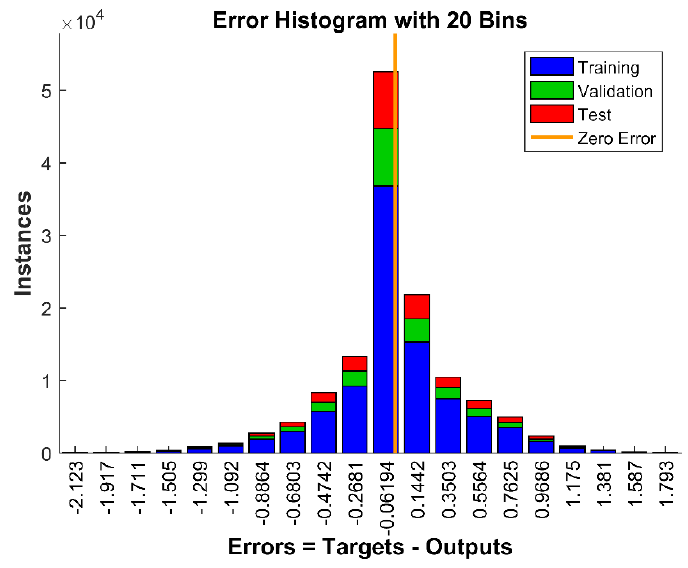
Figure 8. Structure of a 20-bin histogram using the LMBP training algorithm based on ANN.